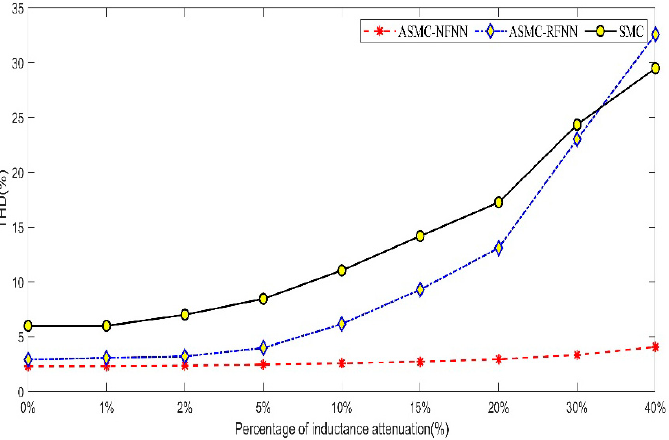
Figure 19. Performance comparison curve of inductance parameter changes.